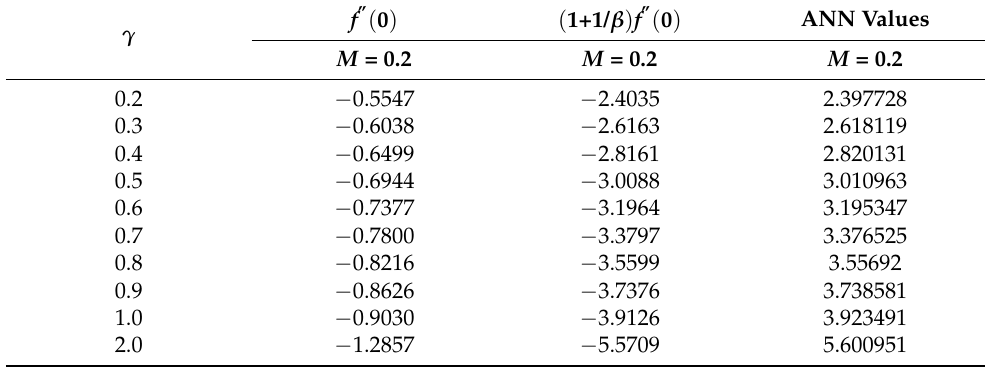
Table 6. Impact of the curvature parameter on the SFC for the magnetic flow field.